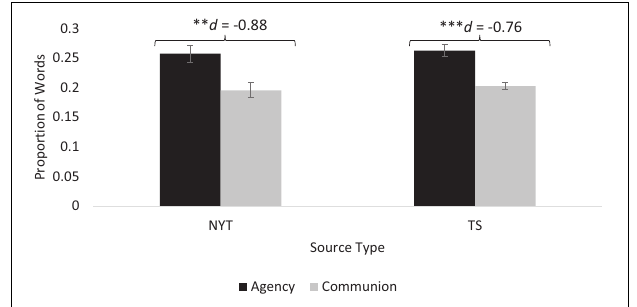
FIGURE 1 | Scientist profiles include more agentic than communal words. Proportion of agency and communion words used with each profile source. Proportion of words is based on LIWC calculations and output (Pennebaker et al., 2015b). ∗∗ p < 0.01, ∗∗∗ p < 0.001.